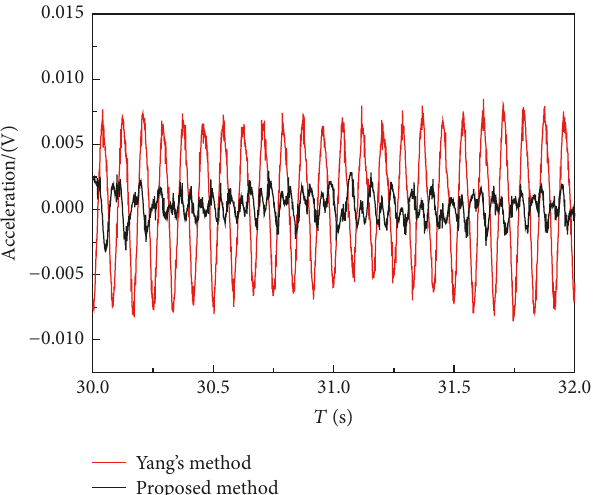
Figure 17: Residual vibration comparison between Yang’ method and the proposed